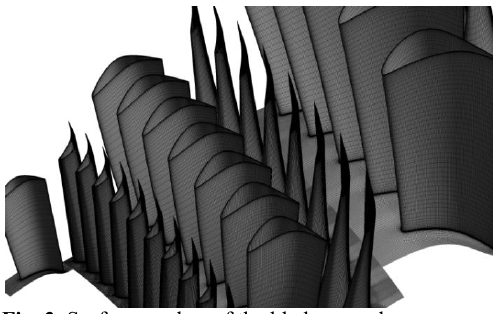
Fig. 3. Surface meshes of the blade cascades